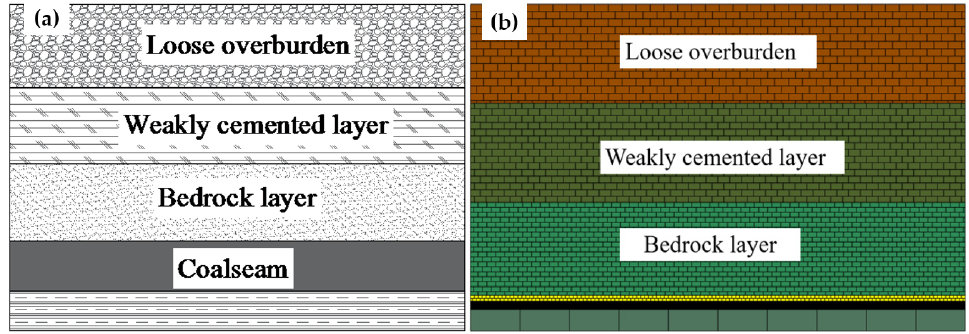
Figure 5. UDEC numerical model. ( a ) Typical stratum conditions in the Xinjiang mining area; ( b ) numerical model. Table 2. Mechanics parameters of the rock strata used in simulation.